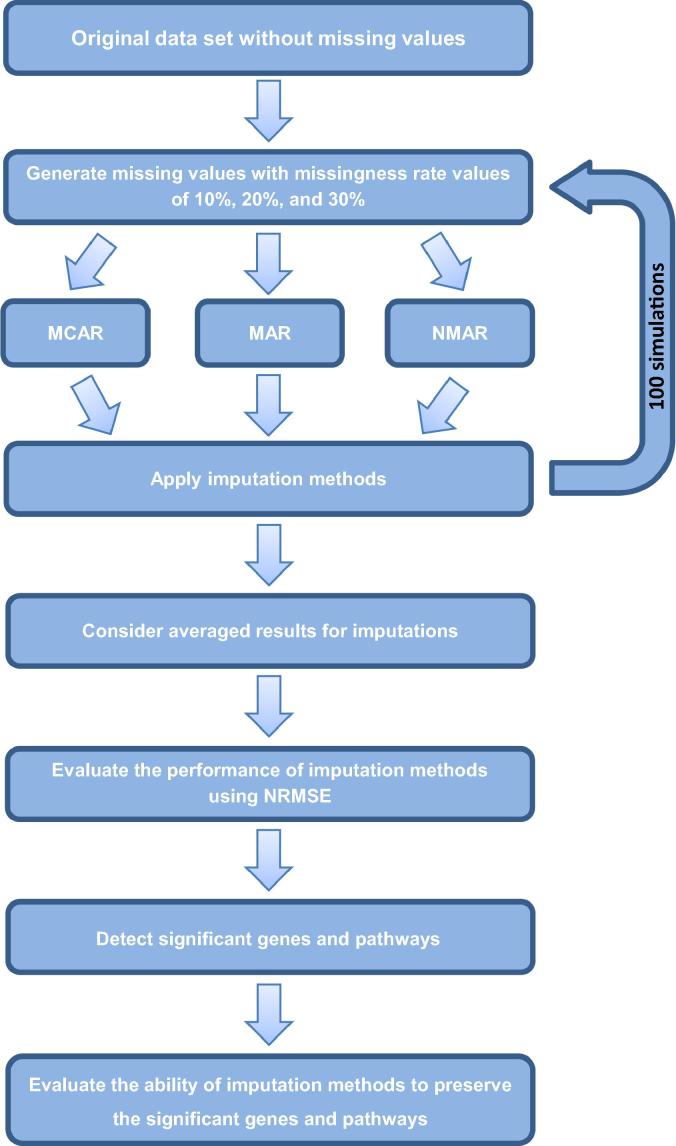
Workflow for data analysis5% of the N genes are selected randomly from the original dataset to generate missing values. MCAR, MAR, and NMAR missingness mechanisms with the missingness rates 10%, 20%, and 30%, respectively, are considered. Then, ten imputation algorithms are applied to complete the datasets. For performance enhancement, the imputation procedures are repeated 100 times. The differences between the imputed and the original values are evaluated using the NRMSE index. Significant genes in the original and imputed datasets are detected using the SAM method and enriched into pathways. Finally, the ability of different imputation methods to preserve the significant genes and pathways is evaluated. MCAR, missing completely at random; MAR, missing at random (MAR); NMAR, not missing at random; NRMSE, normalized root mean square error.